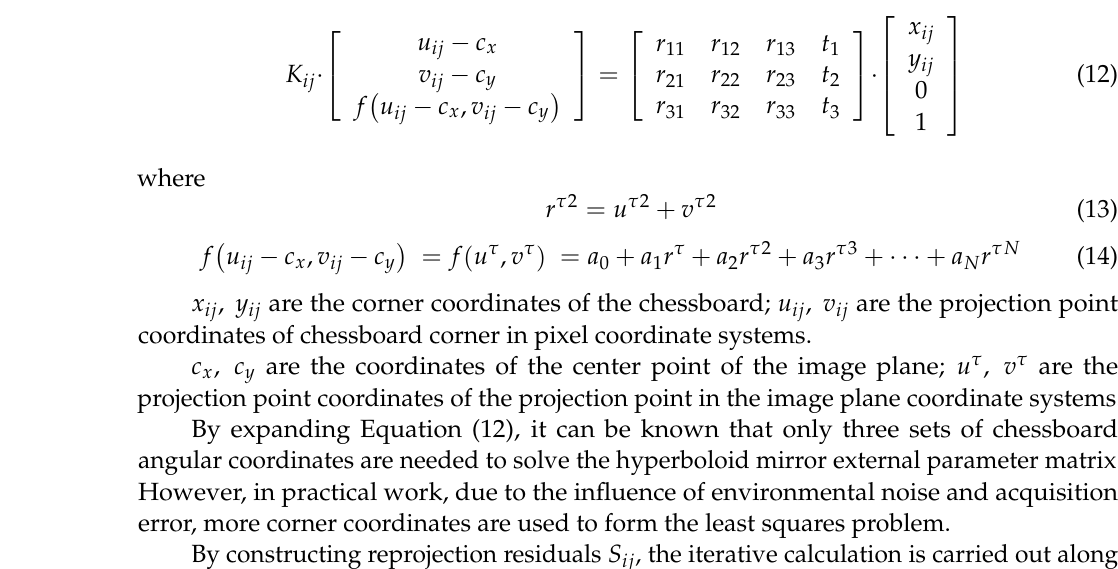
Figure 13. Structure diagram of binocular stereo panoramic calibration. The calibration of binocular stereo panoramic vision systems is easier than the cali- bration of the monocular panoramic vision system. The principle can refer to the ordinary binocular camera calibration method. After the monocular panoramic vision systems are calibrated, the accurate projection relationship can be determined, and various computer vision algorithms can also be used normally. By using the third-party vision detection library Aruco to complete the calibration of the binocular stereo panoramic vision sys- tems, Aruco is an open-source augmented reality library that can be used to complete computer vision tasks such as tracking, recognition, and positioning. This research mainly uses A ruco’s GPS. It should be noted that the camera m odel supported by the Aruco li- brary does not include a panoramic vision system, so the image detection part of the Aruco front end needs to be modified to expand the panoramic image to the hotspot area.